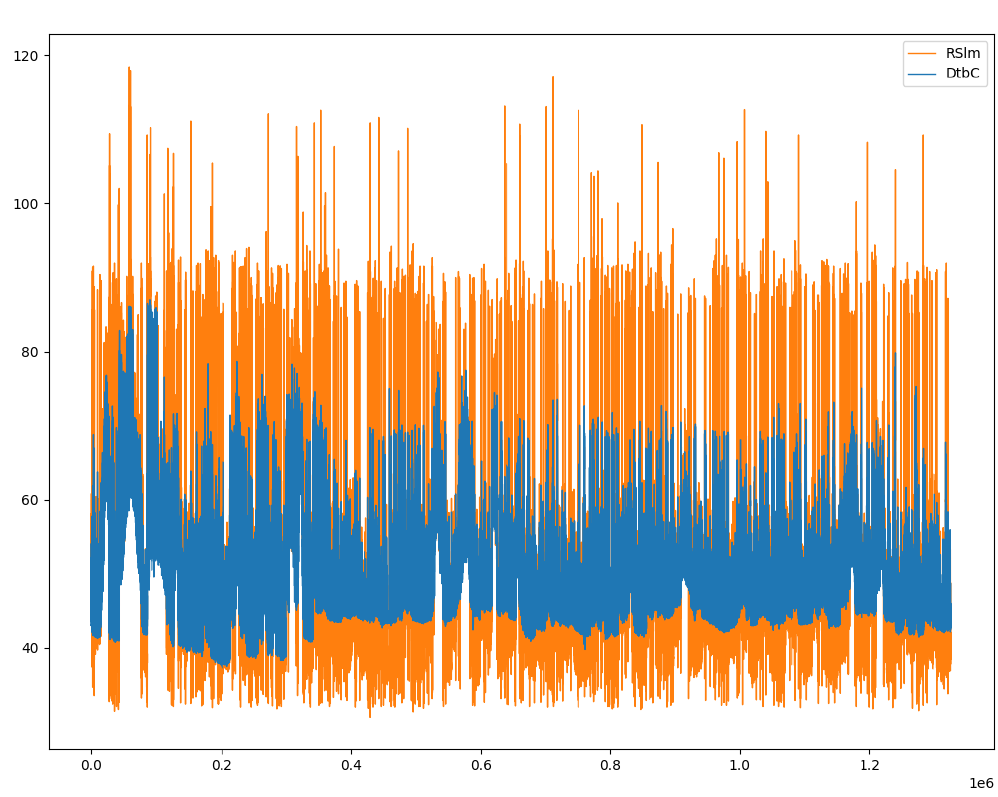
Figure 2. The amount of device to be calibrated (DtbC) and reference sound level meter (RSlm) data collected. The samples are aligned over